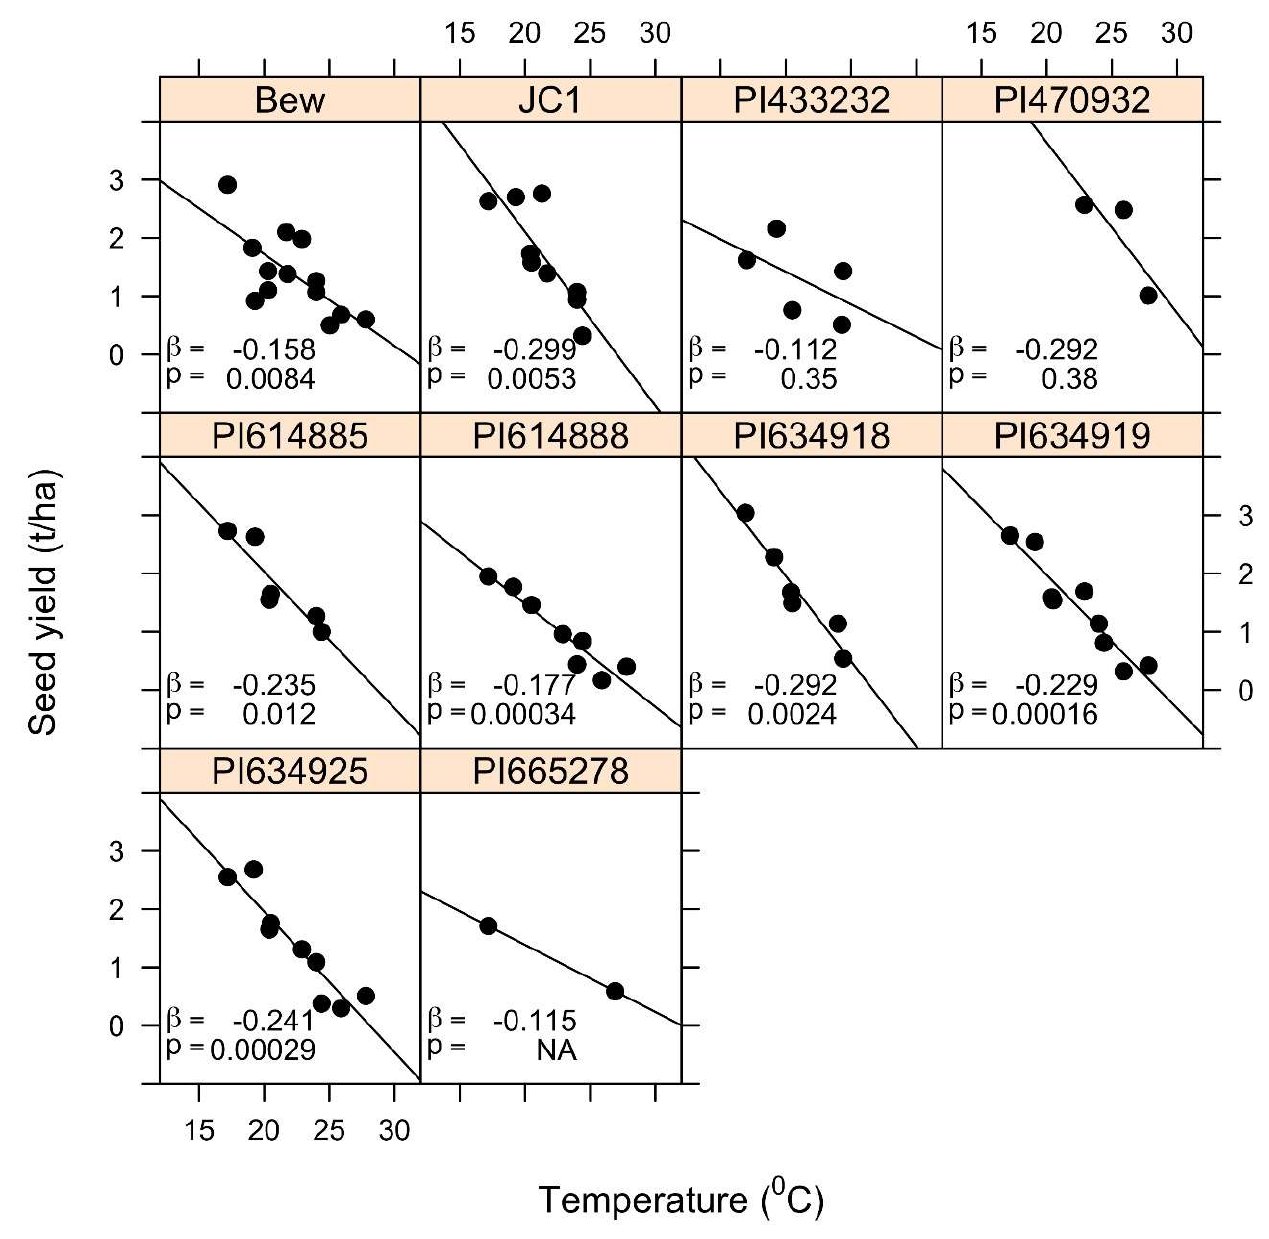
Figure 3. Relationship between seed yield (t/ha) and average mean daily temperature ( ◦ C) during the seed development stage for selected field trials where water was presumed not to be limiting production (i.e., all irrigated field trials, excluding Leeton—March, and including the rain-fed site at